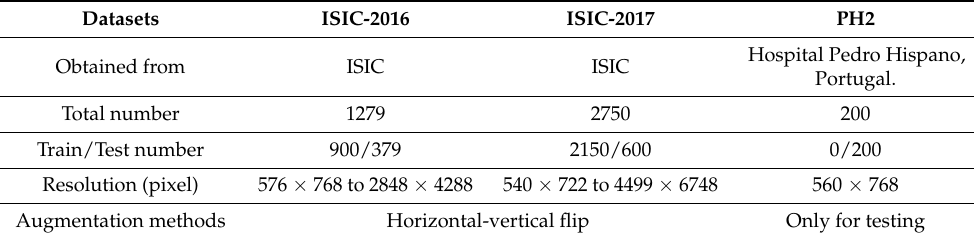
Table 1. The specific information of the ISIC-2016 dataset, ISIC-2017 dataset, and PH2. Datasets ISIC-2016 ISIC-2017 PH2 Obtained from ISIC